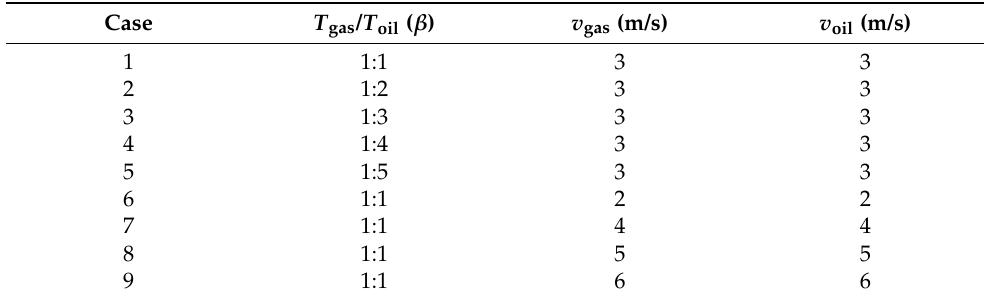
Table 2. Simulation